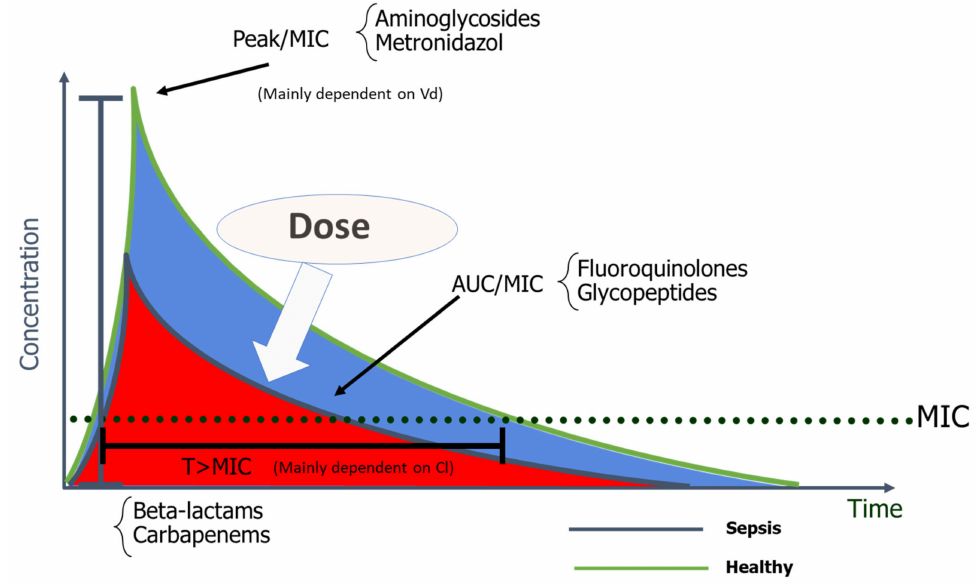
Figure 2. Pharmacokinetics and pharmacodynamics: After an antibiotic infusion, a ratio between the peak concentration and the minimal inhibitory concentration, the area under the concentration–time curve and the minimal inhibitory concentration, and the time the antibiotic concentration is above the minimal inhibitory concentration can be defined. These three parameters all decreased in septic patients, with an increased volume of distribution and clearance. The only secure way to achieve effective antibiotic concentration is to adjust the dose. MIC—minimal inhibitory concentration; T > MIC—time that the antibiotic concentration is above the minimal inhibitory concentration; Vd—Vole of distribution;